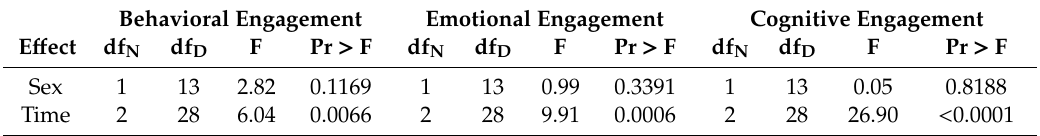
Table 3. Results of mixed-e ff ects model repeated measures (MMRM) analysis of each of the three dimensions of